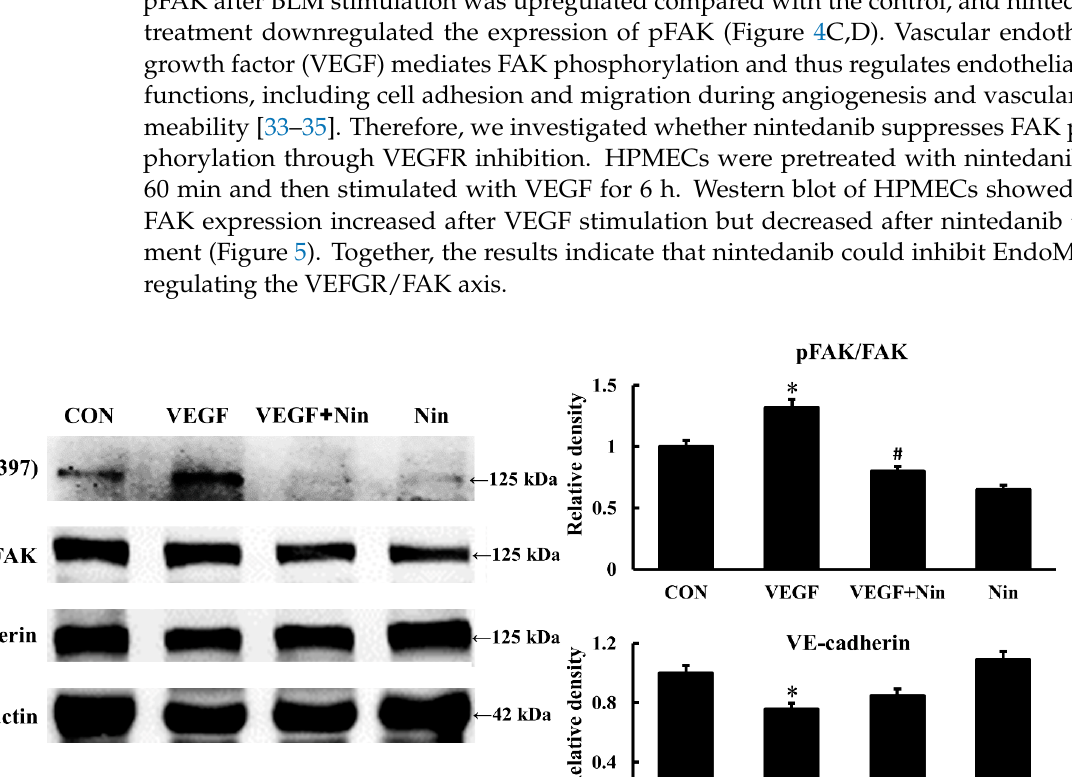
Figure 6. In vitro EndoMT is promoted by IPF but inhibited by nintedanib. Representative IF stain- ing images of VE-cadherin, α -SMA, and TGF- β in HPMECs treated with IPF serum (from patients with IPF) or nintedanib alone or in combination. Scale bars, 100 µm. α -SMA, alpha smooth muscle actin; EndoMT, endothelial mesenchymal transition; HPMEC, human pulmonary microvascular en- dothelial cell; IPF, idiopathic pulmonary fibrosis; TGF- β , transforming growth factor beta; VE-cad- herin, vascular endothelial cadherin. Green, VE-cadherin; red, α -SMA; blue, DAPI. 3. Discussion IPF is an irreversible and dismal disease in which normal pulmonary architecture is gradually lost and replaced by fibrotic tissue with fibroblast/myofibroblast proliferation